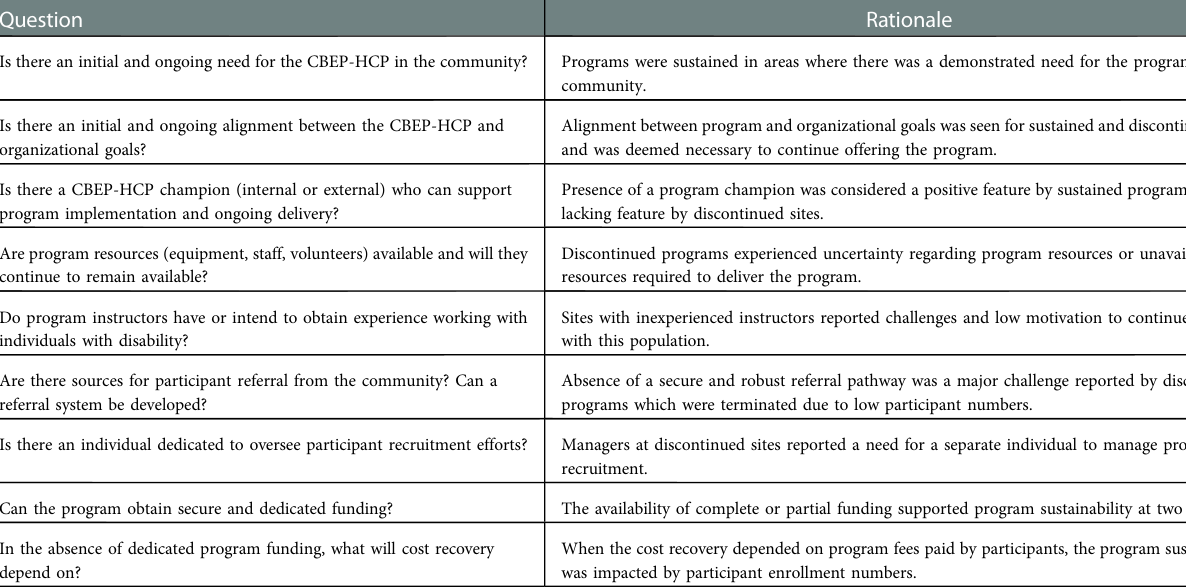
TABLE 7 Questions to consider to understand the potential for program